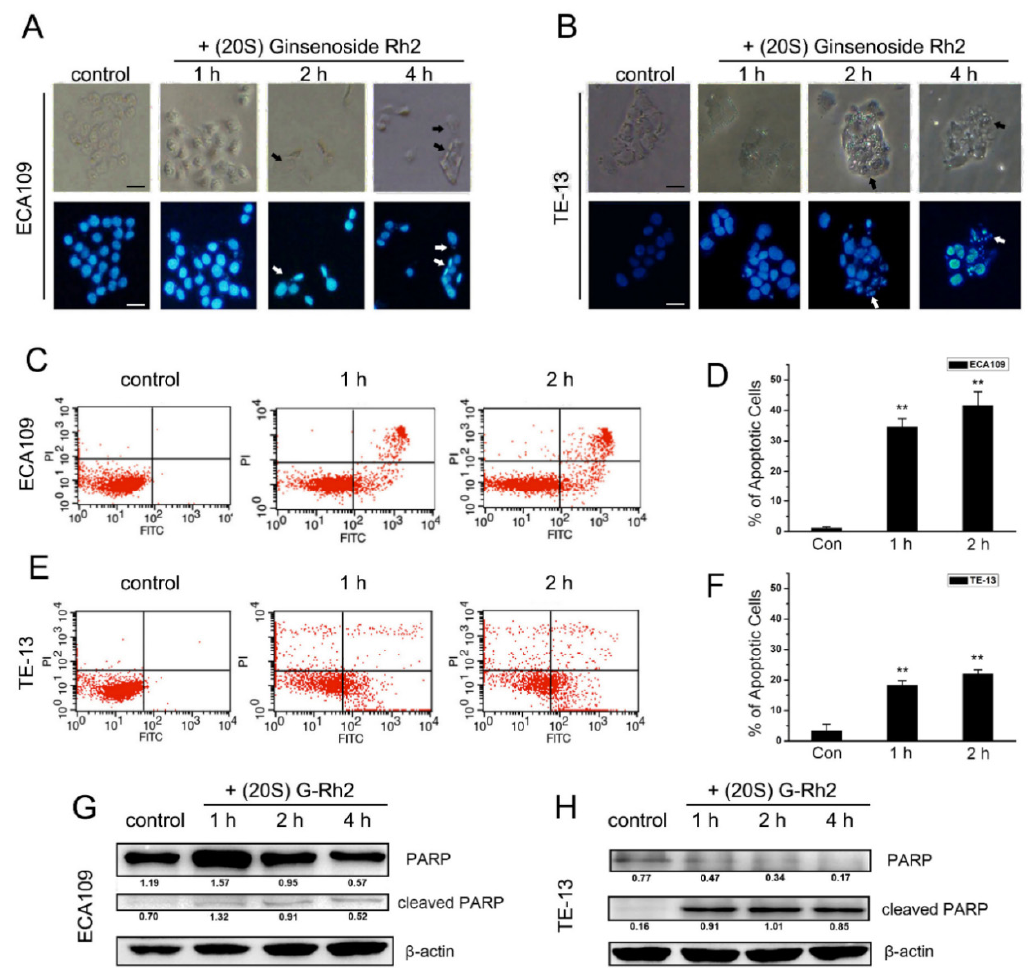
Figure 2. (20S) ginsenoside Rh2-induced apoptosis in human esophageal cells. ( A , B ) ECA109 and TE-13 cells were treated with 7.5 μ g/mL (20S) G-Rh2 for 1, 2, and 4 h. Cells were stained with DAPI and photographed by a fluorescence microscope. Scale bar: 20 μ m; ( C – F ) cells were stained with Annexin V-FITC/PI and analyzed by flow cytometry after being treated with 7.5 μ g /mL G-Rh2. Cells at the early stage of apoptosis were positive for Annexin V-FITC and negative for PI. Cells that were positive for both Annexin V-FITC and PI were at the end stage of apoptosis; ( G , H ) as the substrate of Caspase-3, cleaved PARP was identified by Western blotting. ** p < 0.01.